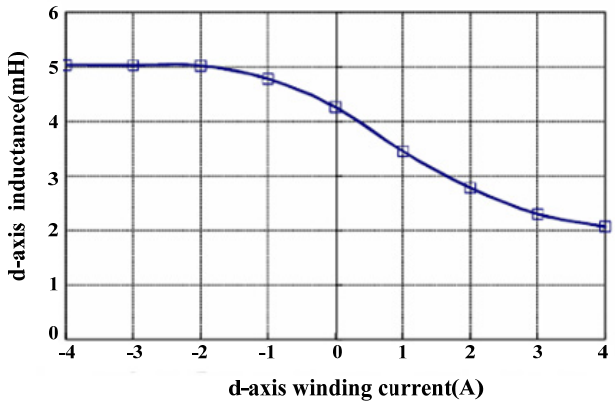
Figure 1. The relationship between d-axis inductance and winding